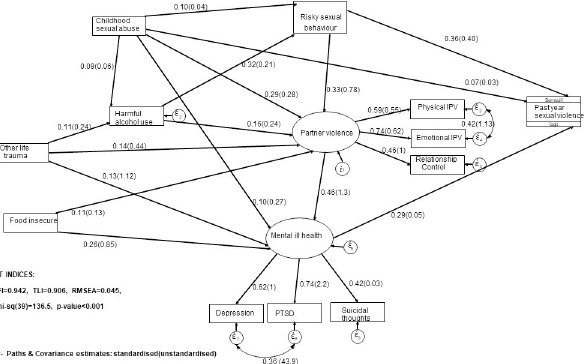
Fig 2. Structural pathways between SV experiences and inter-related vulnerability factors (female students survey: South African Technical Vocational Education and Training (TVET) colleges and universities (2018–2019)).